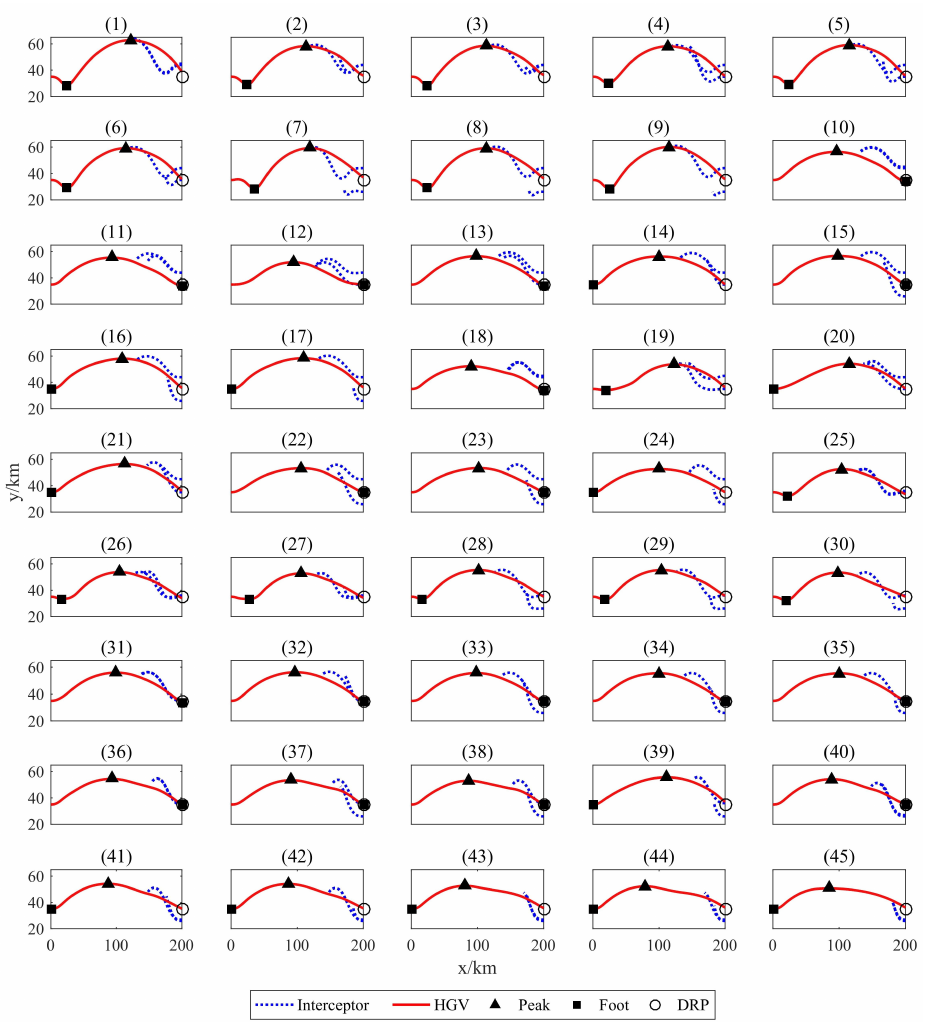
Figure 9. Vertical motion of the HGV and interceptors in the test cases. The strategies fall into two categories: S-curve (dive–leap–dive) and C-curve (leap–dive). There is also a specific pattern to the